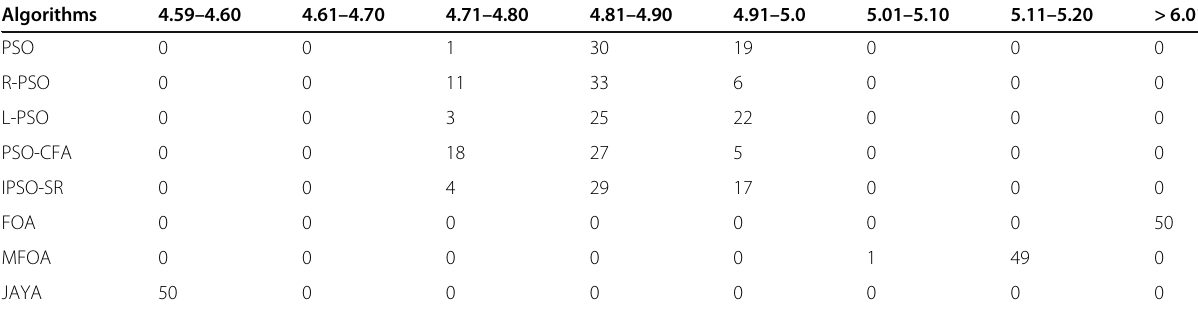
Table 6 Frequency of convergence for the IEEE 30 bus system case 2 in 50 trial runs Algorithms